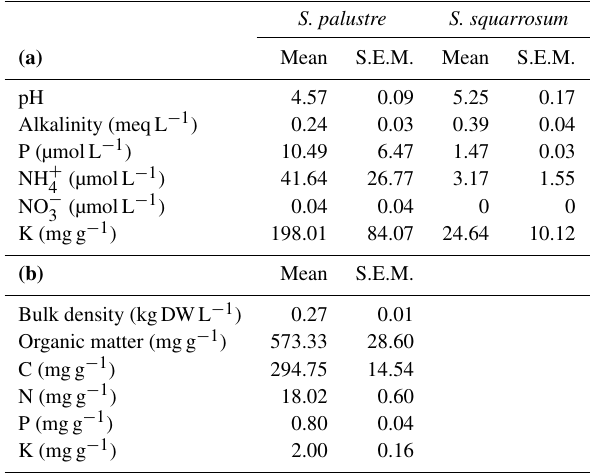
Table 1. (a) Field conditions of pore water in the Sphagnum veg- etation layer at the collection site (N = 4). (b) Properties of peat monoliths in the experiment (N =